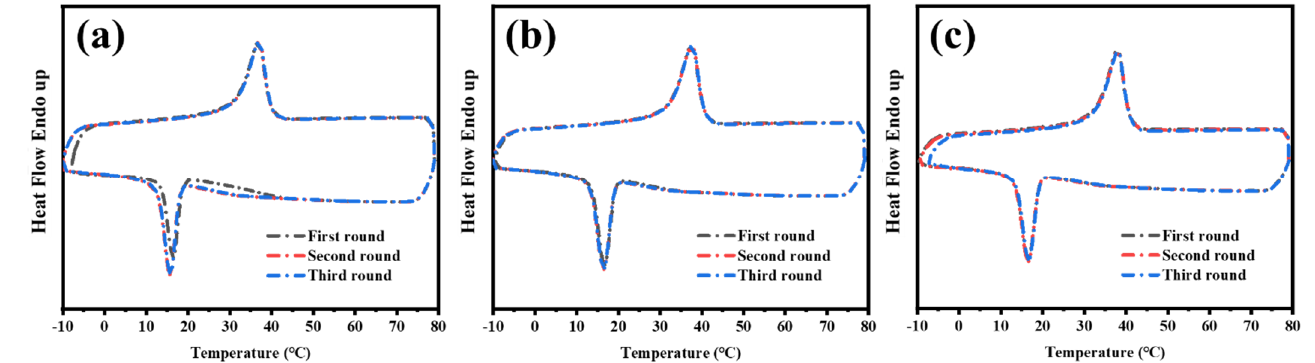
Figure 9. DSC curves of PBHA-Cn copolymers in three cycles of cooling and reheating: ( a ) PBHA- C5/PBT = 33/67, ( b ) PBHA-C5/PBT = 30/70, and ( c ) PBHA-C5/PBT = 27/73.